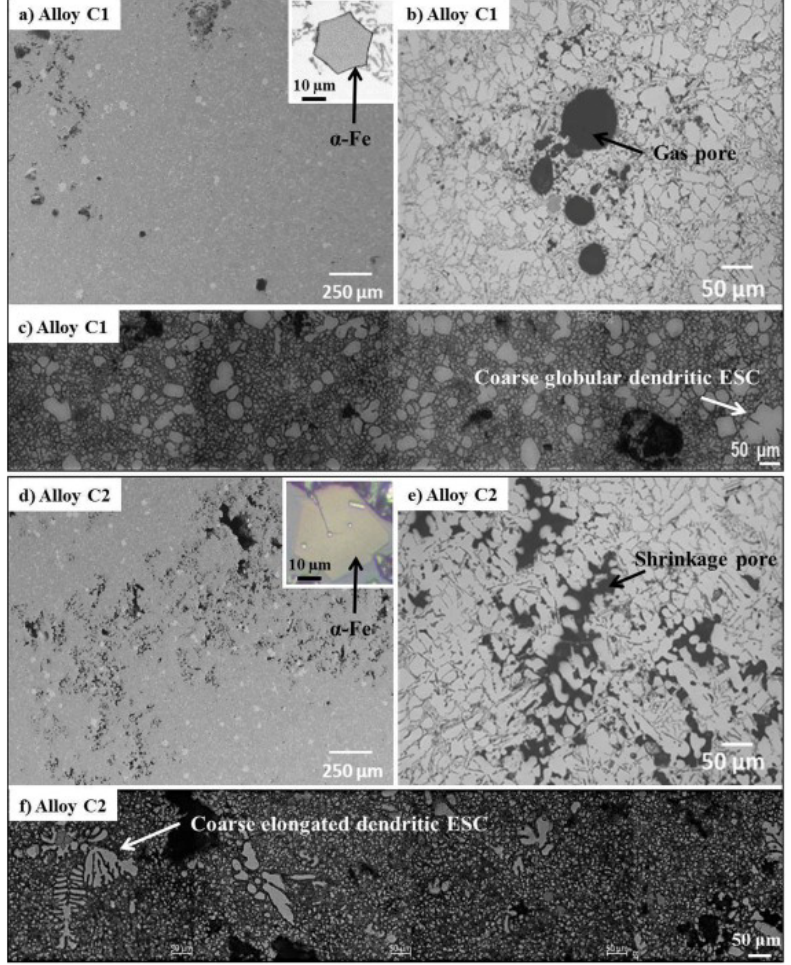
Figure 6. Commercial SAA AlSi9Cu3(Fe) microstructure. ( a , b ) C1 with 0.9 wt.% Fe and ( d – f ) C2 with 4.2 wt.% Fe. Reprinted with permission from [58]. 2022, Elsevier. Zhao et al. investigated the effect of Fe content on the evolution of intermetallic phases in the gravity- and squeeze-cast AlMg3Mn1(Fe) alloys. Al 6 (FeMn) is the Fe-rich